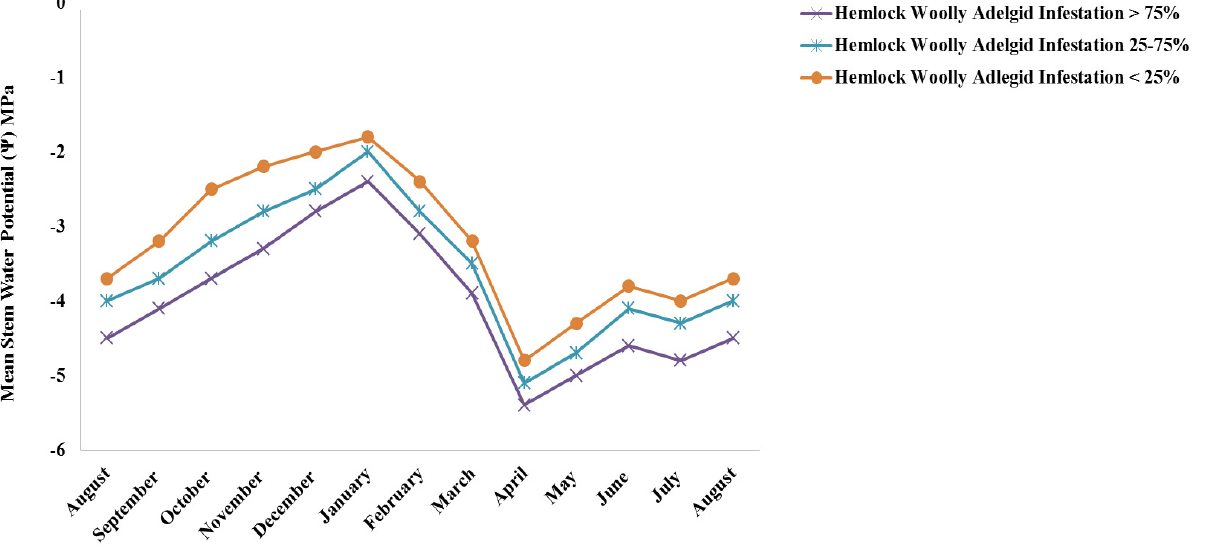
Figure 2. Temporal variation of adjusted water stress as a function of adjusted mean stem water potential (Ψ) as an indicator of water stress from August 2011 to August 2012. The more negative the stem water potential (Ψ), the more water stress is occurring in the tree. Mean stem water potential (Ψ) was significantly different between all infestation levels within each month (Student-Newman-Keuls Test; p <